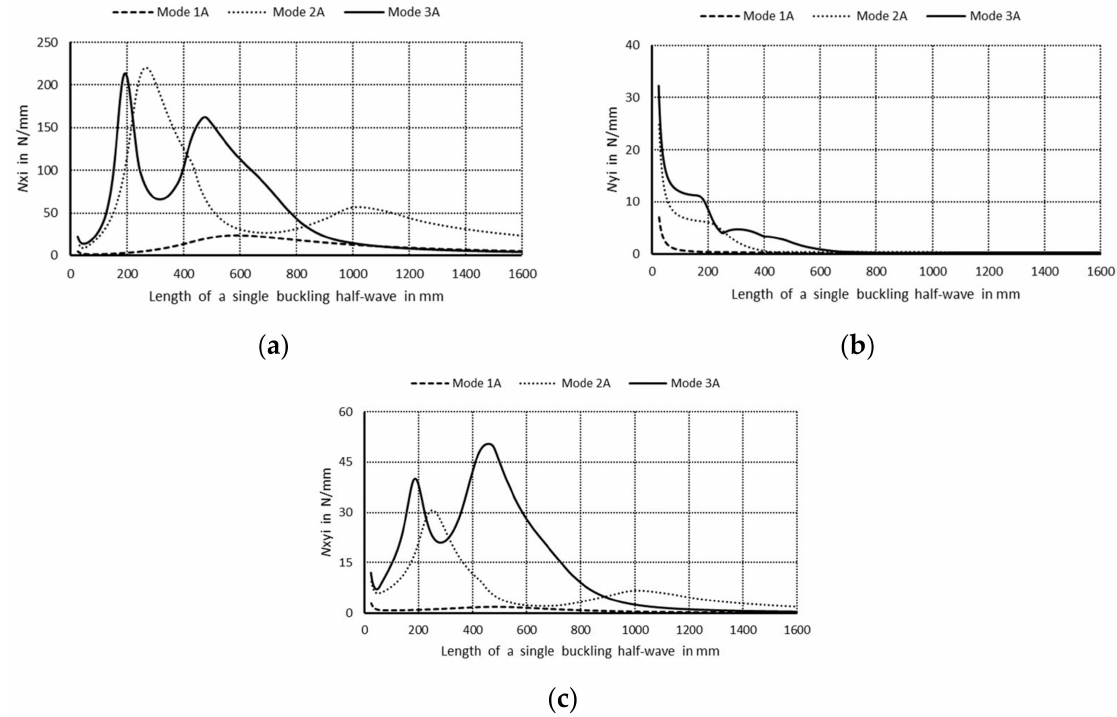
Figure 5. Maximal absolute values of membrane forces in N/mm for anti-symmetrical buckling modes: ( a ) longitudinal forces N xi , ( b ) transverse forces N yi , and ( c ) shear forces N xyi as a function of the length of a single buckling half-wave in